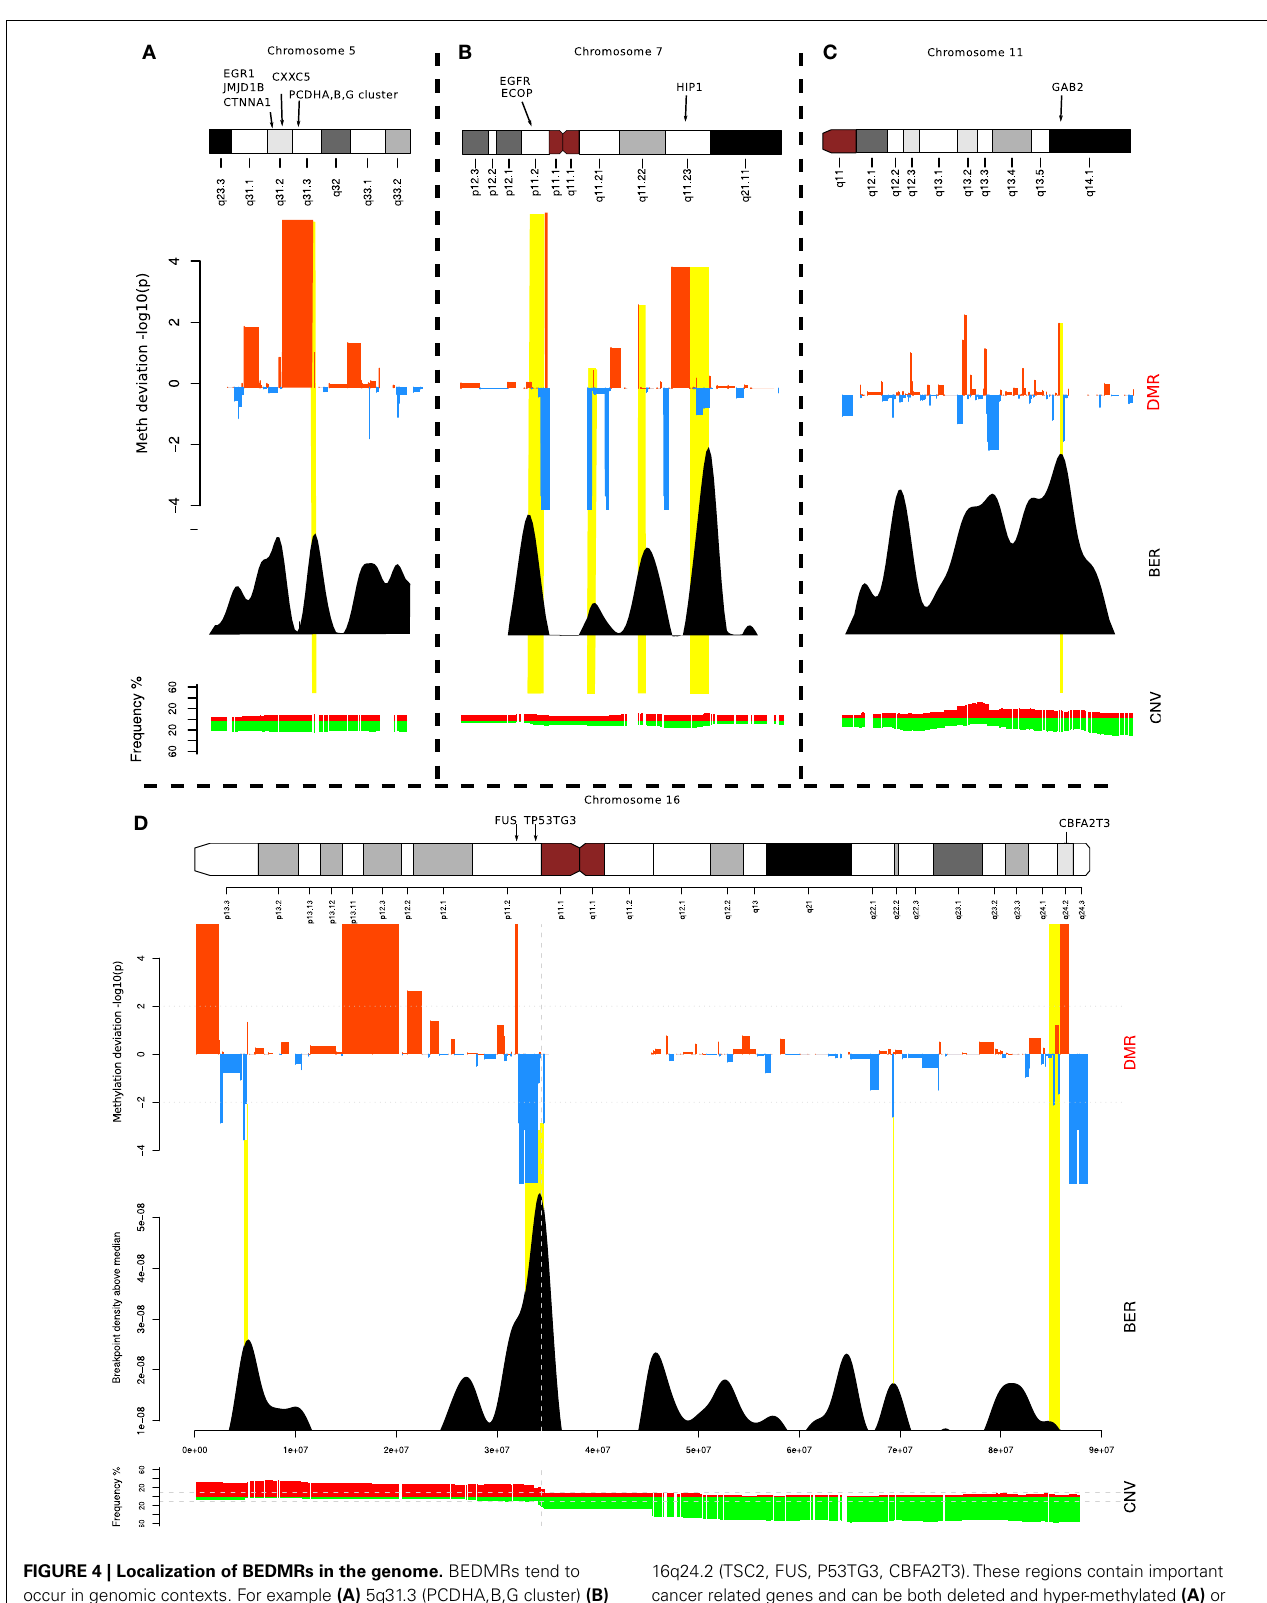
FIGURE 4 | Localization of BEDMRs in the genome. BEDMRs tend to occur in genomic contexts. For example (A) 5q31.3 (PCDHA,B,G cluster) (B) 7p11.2 and 7q11.23 (EGFR, HIP1) (C) 11q14.1 (GAB2). (D) 16p13.3, 16p11.2,